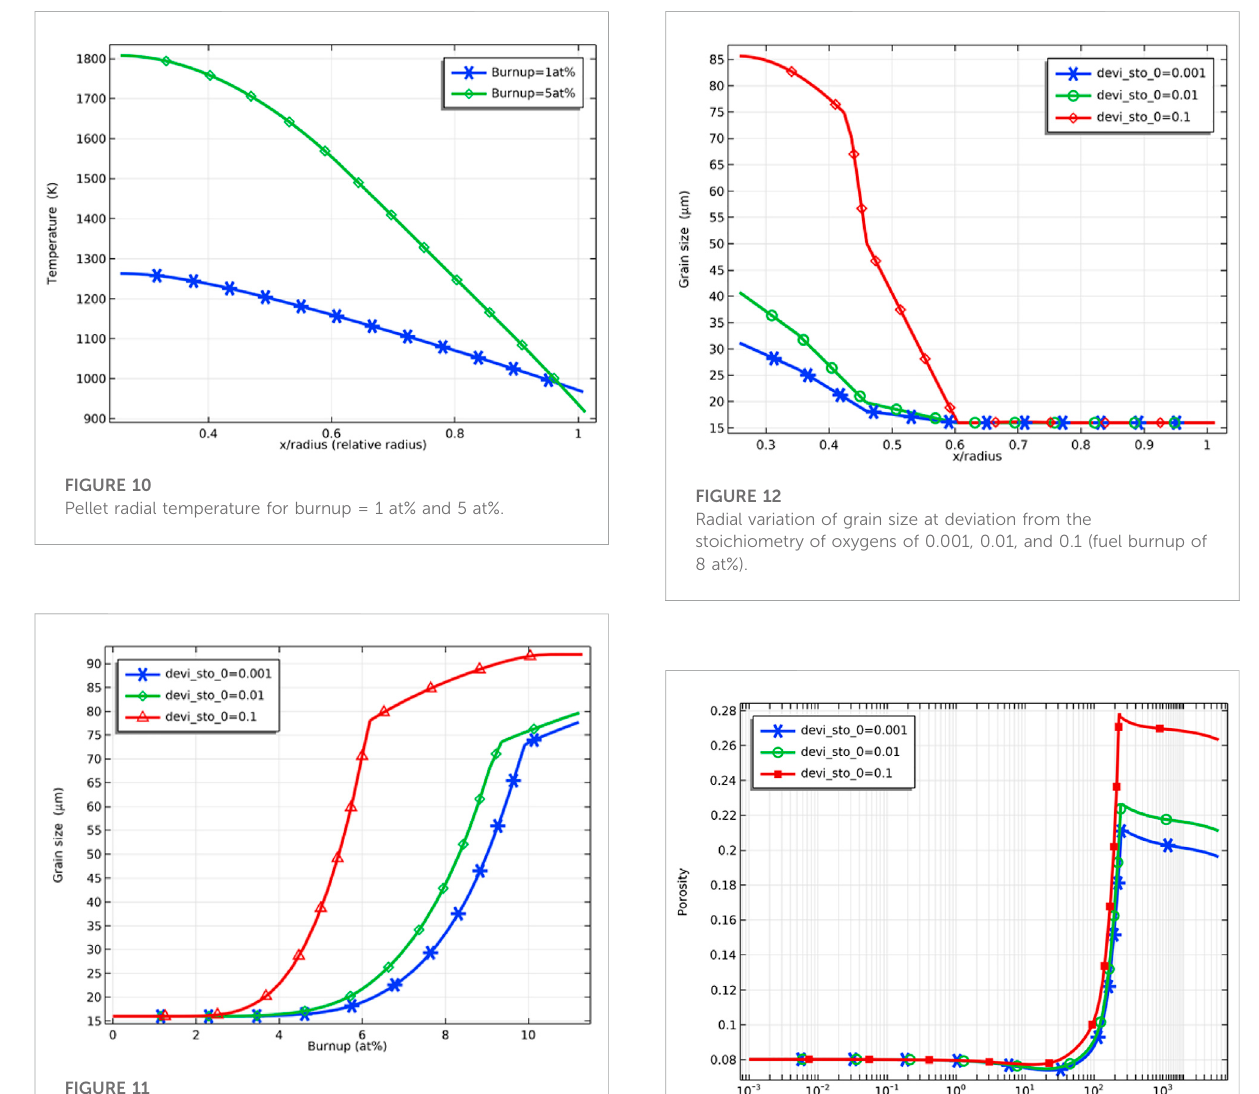
FIGURE 11 Variationofpelletinnersurfacegrainsizewithfuelburnupfor deviation from the stoichiometry of oxygen of 0.001, 0.01 and 0.1.